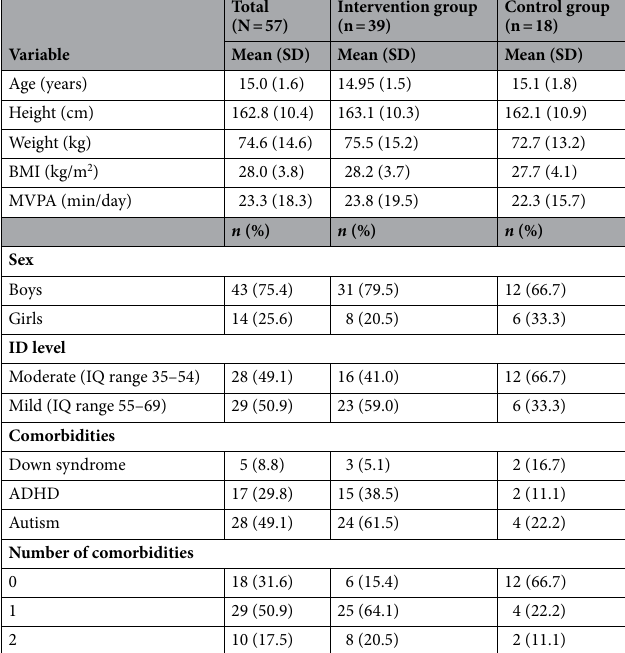
Intervention (n = 39) Control (n = 18) Outcome